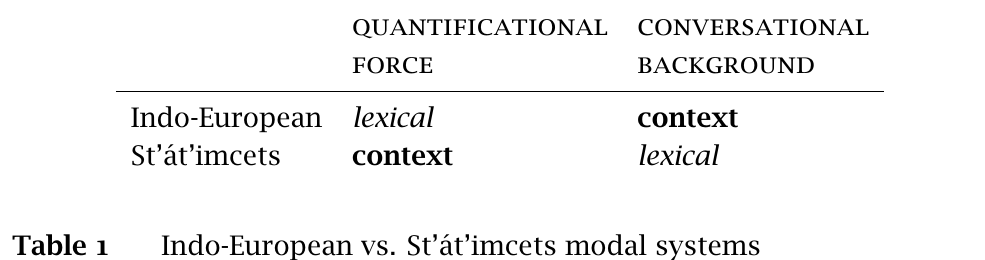
Table 1 Indo-European vs. St’át’imcets modal